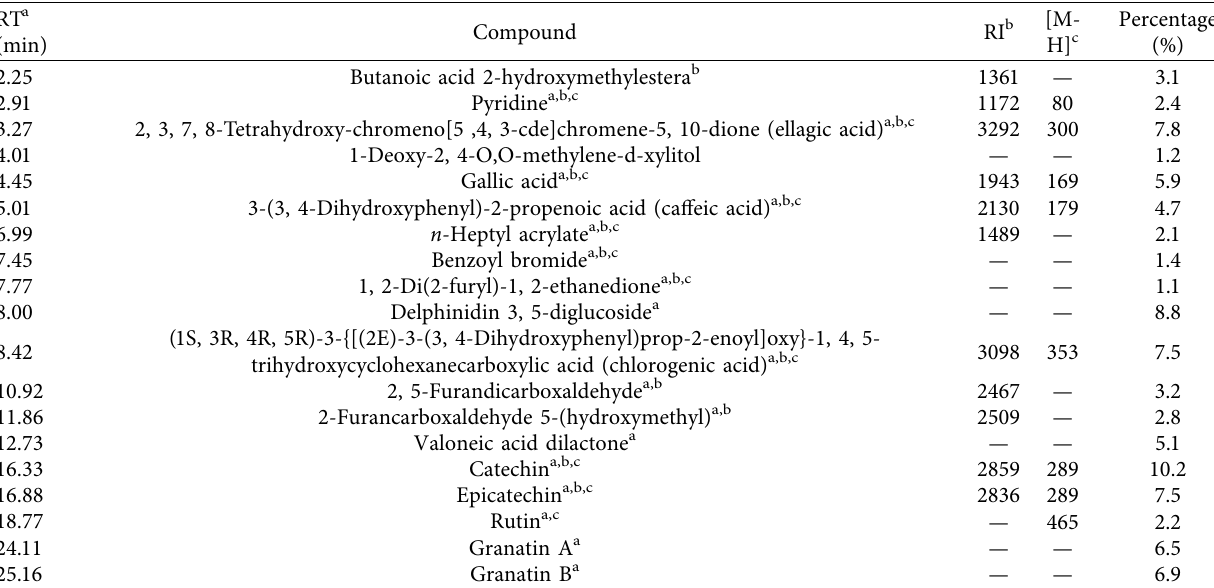
a RT: retention time; STD: standard compound; NIST14 (compound identified by RI comparison with library). b RI: Kovats retention indices (RI) determined using a commercial hydrocarbon mixture (C9–C25) on the HP-5MS column (compound identified by Kovats retention indices comparison with literature values). c MS: compound identified by mass spectra comparison with the Wiley library. Table 5: LC-MS analysis results of the pomegranate peel